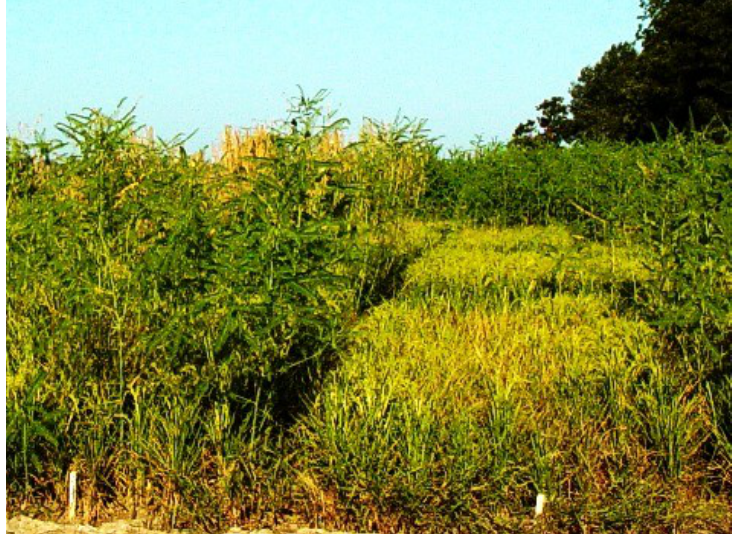
Figure 5. Photograph depicting season-long control of hemp sesbania in rice by a Myrothecium verrucaria mycelial formulation ( right ), and untreated ( left